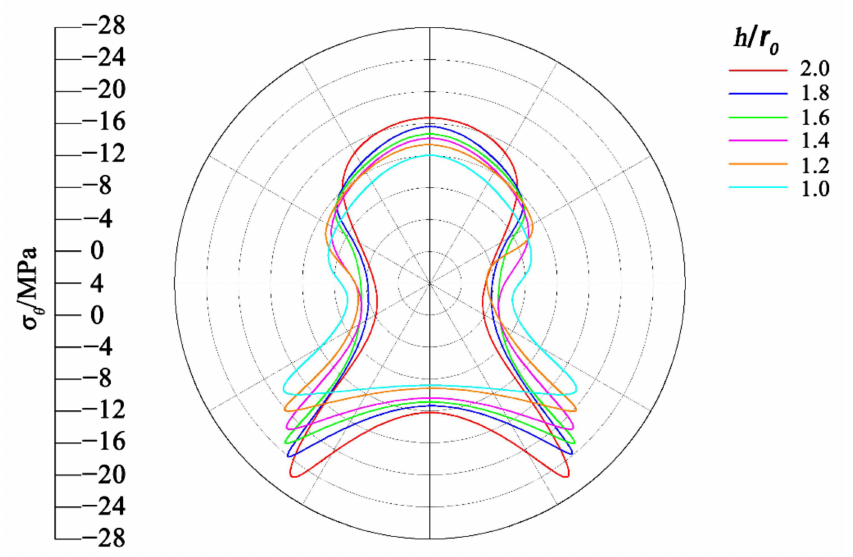
Figure 13. Variation of tangential stress of high side wall caverns with different height–span